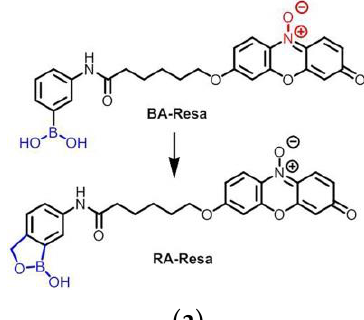
( d ) Figure 36. ( a ) Structure of probe TJM; ( b ) Fluorescence spectra of TJM; ( c ) Fluorescence imaging of HeLa cells; ( d ) Fluorescence imaging of mice. Reproduced with permission from [155]. Copyright 2022 Elsevier B.V. 10. Fluorescent Probe for Detecting NADH